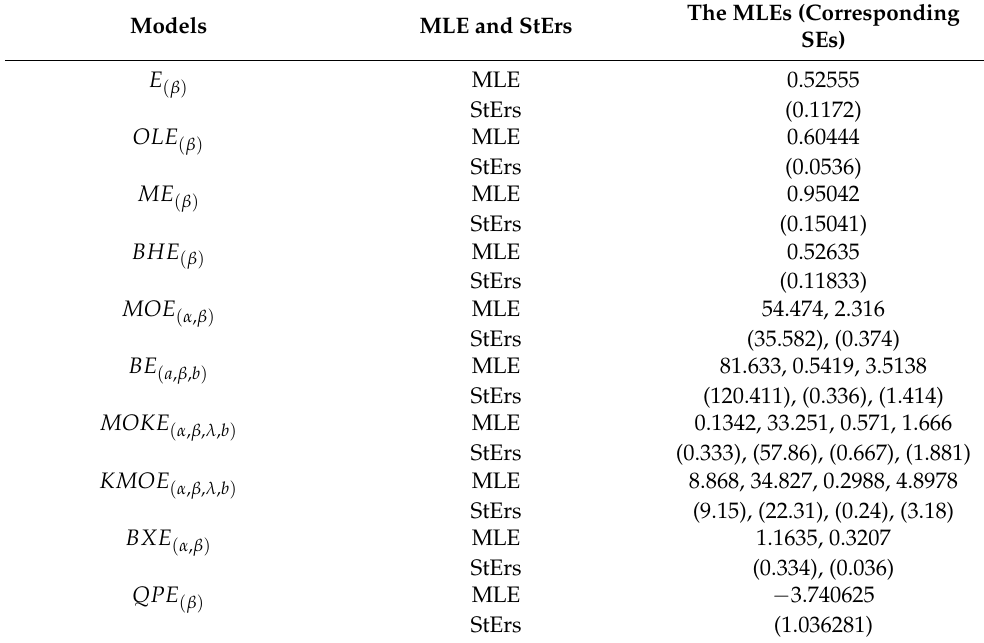
Table 6. MLEs and SE for the relief times data.